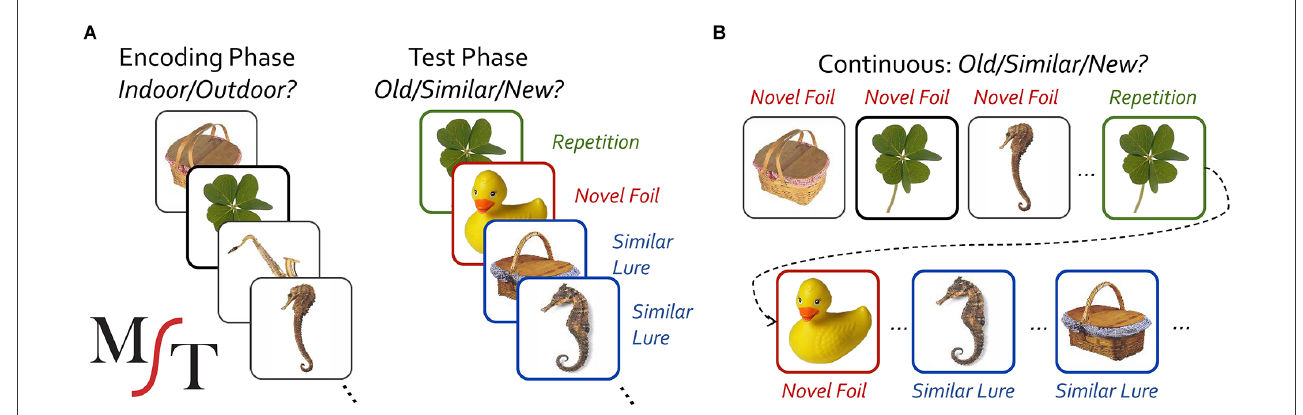
FIGURE1 Schematic diagram of the study-test (A) and continuous (B) version of the Mnemonic Similarity Task (MST).